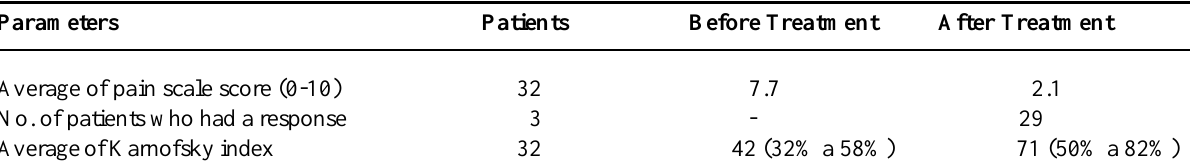
Table 3 - Summary of patients who underwent treatment with